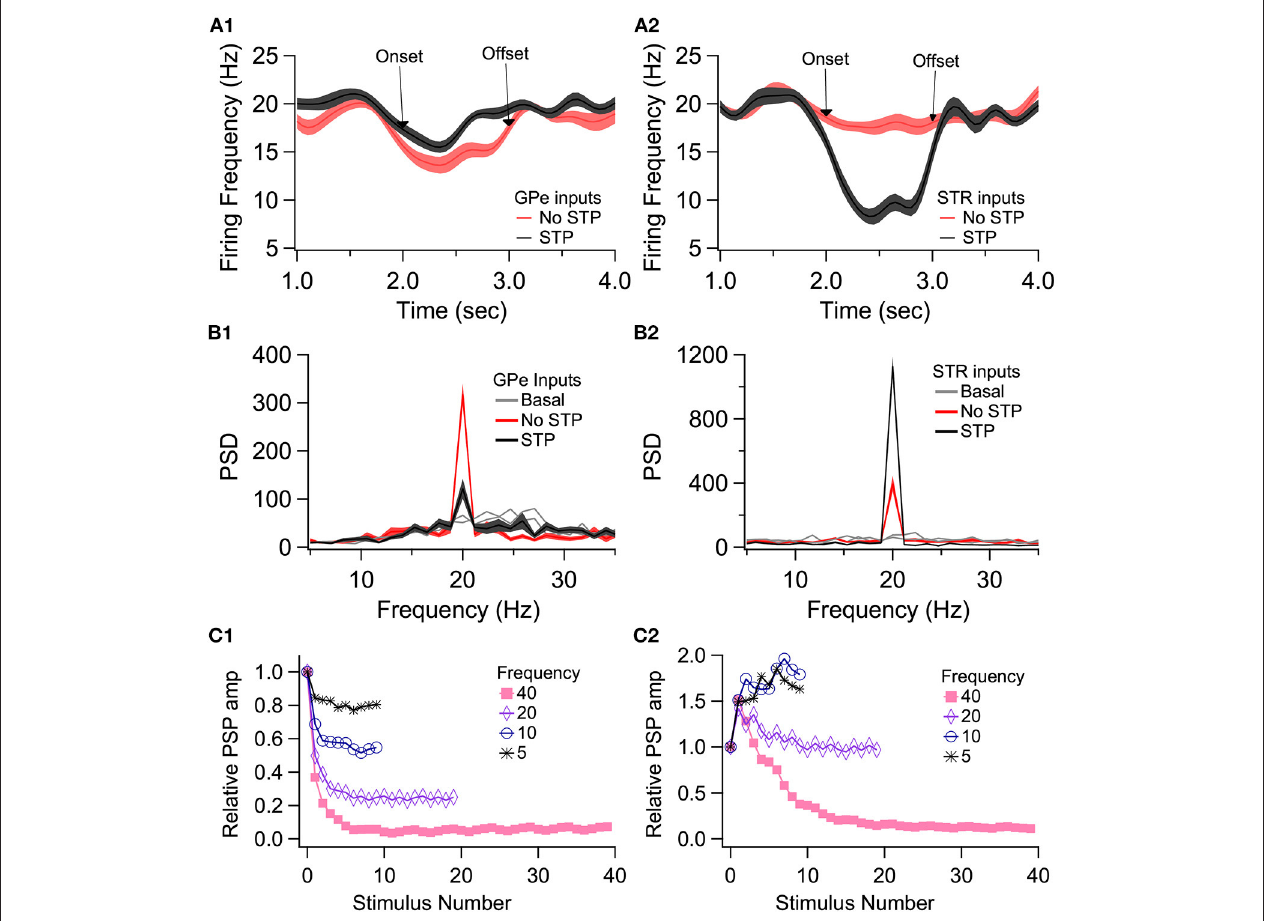
FIGURE 8 | Effect of short term plasticity (STP) on EP firing frequency and phase locking. EP neurons were simulated in response to log normally distributed GPe (18Hz), SPN (4Hz), and STN (18Hz) synaptic input, with an additional 20Hz train from either GPe (A1, B1) or Str (A2, B2) delivered between 2 and 3s (marked by arrows labeled onset and offset). (A) Effect of STP on EP firing frequency. STP reduced the effect of 20Hz GPe inputs on EP firing and enhanced the effect of 20Hz Str inputs on EP firing. Shading shows + /– 1 SEM. (B) Amplitude of the PSD peak at 20Hz (PSD calculated from the data segment between 2 and 3s) shows that STP reduced phase locking to GPe inputs but increased phase locking to Str inputs. Basal shows the PSD measured from the same simulations using data segments from 1–2 to 3–4 s. (C1, C2) The STP implemented in the model produces similar frequency dependence of PSP amplitude as recorded